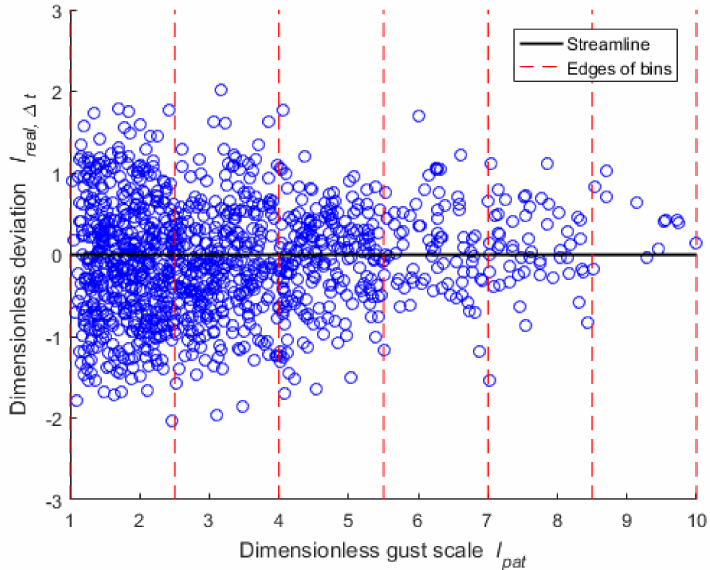
Figure 7. Scatter plot of normalized deviations and patch scales. The streamline overlays the line with the deviation l real , ∆ t equal to zero. The red dashed lines imply the edges of the bins. The average dimensionless scales at the bins are 1.75, 3.25, 4.75, 6.25, 7.75, and